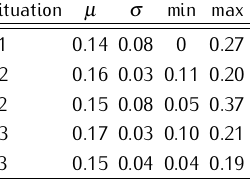
Table 6. The average, minimum and maximum number of turns per second between the participants and the researcher during T1-T3 and S2-S3.